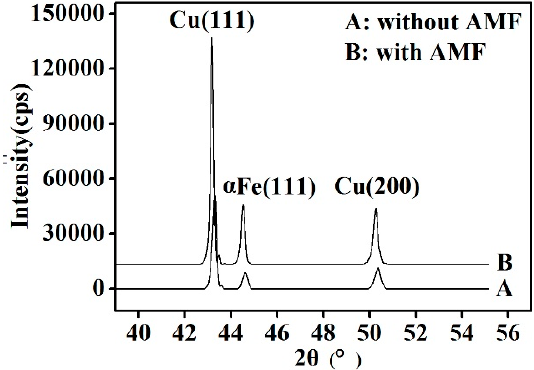
Figure 5 . XRD patterns of Cu ‐ 14Fe composites.